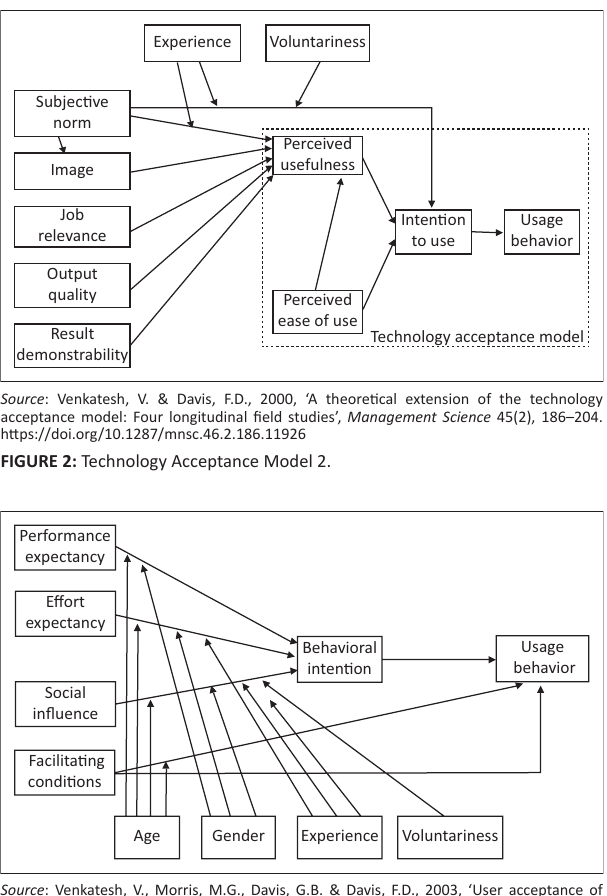
FIGURE 3: Unified Theory of Acceptance and Use of Technology model.